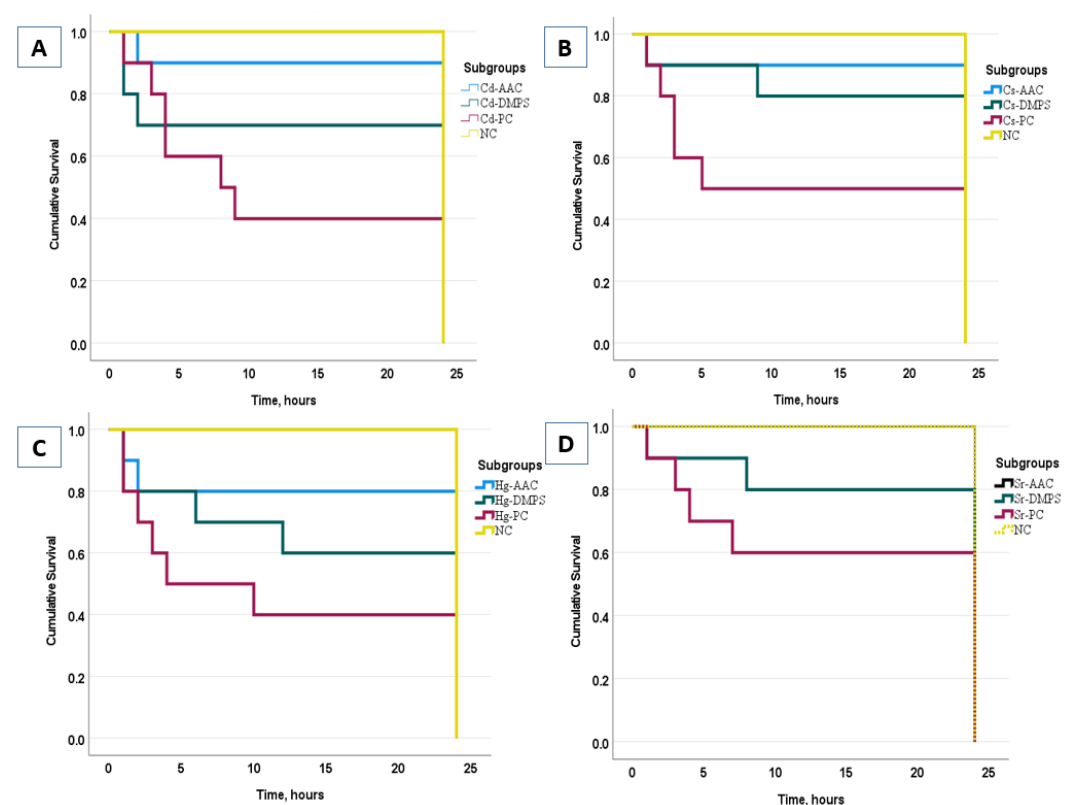
Figure 2. Plots of the Kaplan–Meier product limit estimates of the survival of animals for the Cd ( A ), Cs ( B ), Hg ( C ), and Sr ( D ) subgroups.